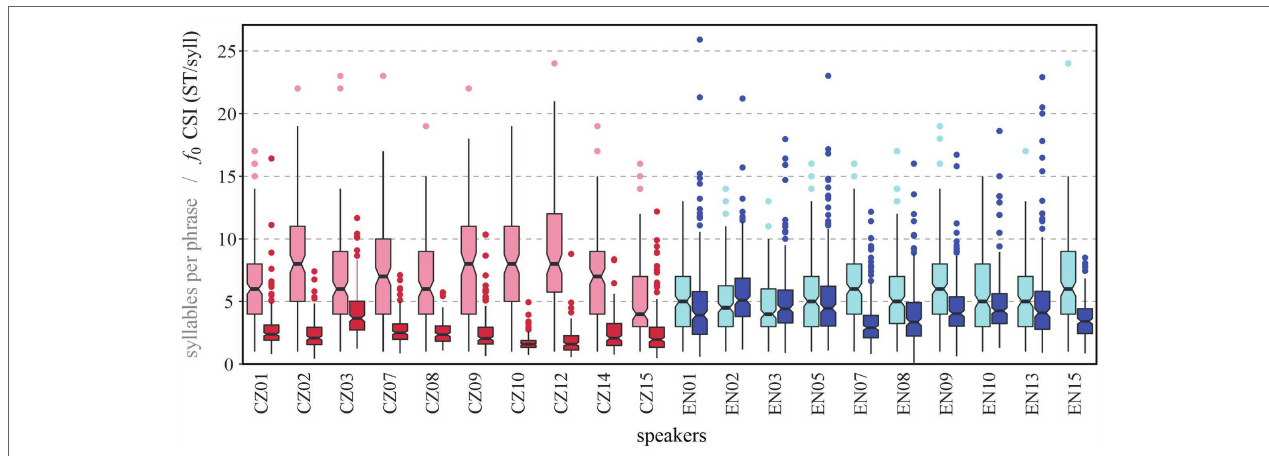
FIGURE 9 | Prosodic phrase length in syllables (boxplots on the left in lighter colors) and cumulative slope index (CSI) of f 0 (boxplots on the right in darker colors) for individual speakers in BI4-d